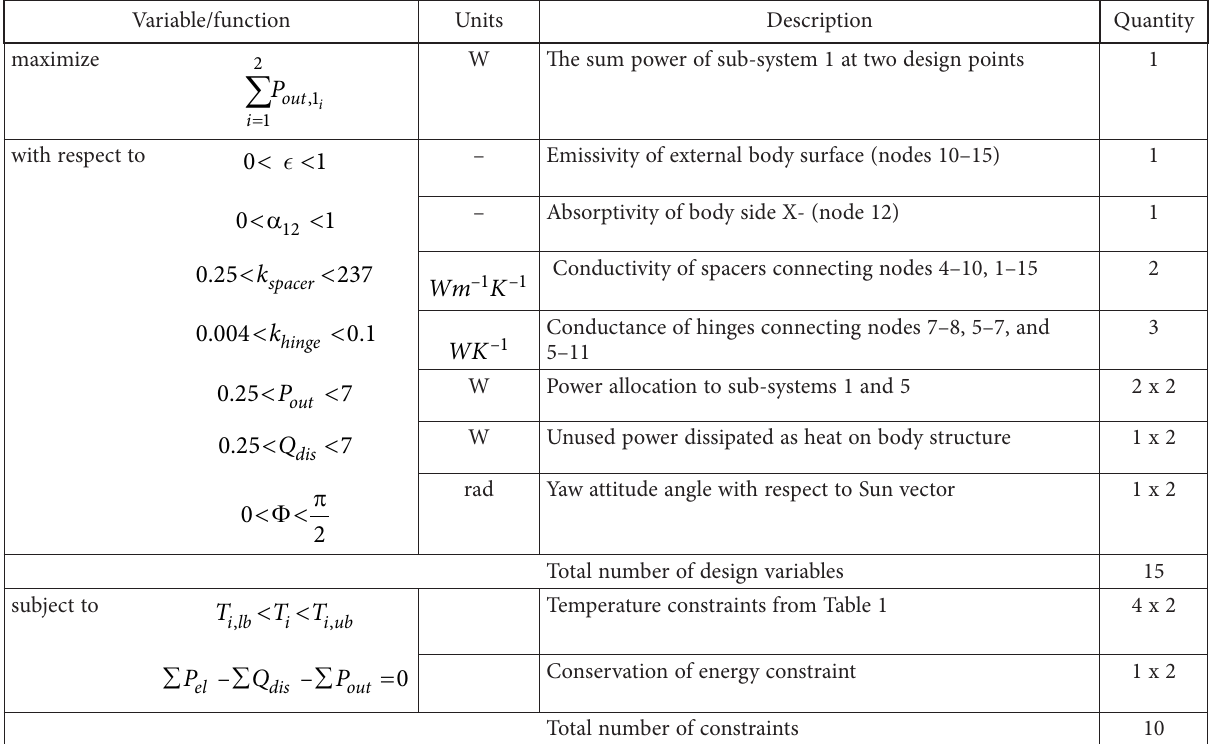
Table 3. Example optimization problem